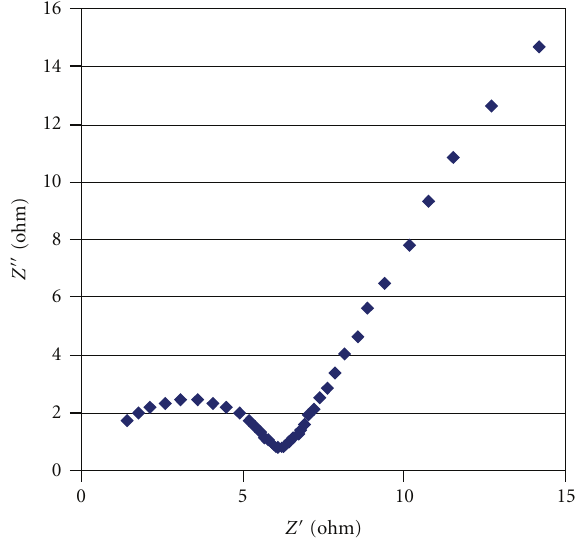
Figure 4: Nyquist plot fromimpedance testing of EDLC CWF-GF/F capacitor between 10kHz and 1Hz; each carbon electrode has an area of 2cm 2 and mass of 40